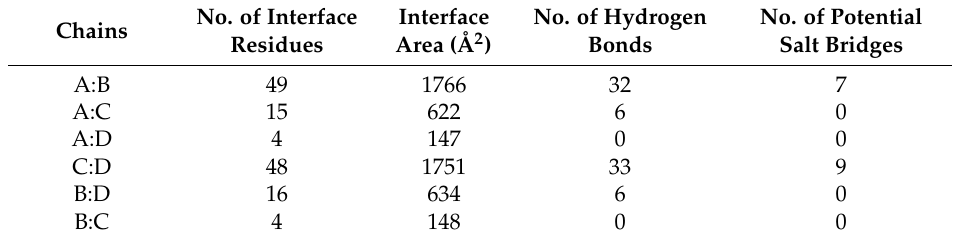
Table 1. Statistics of intermolecular interactions in the asymmetric unit of the avidin/B9P